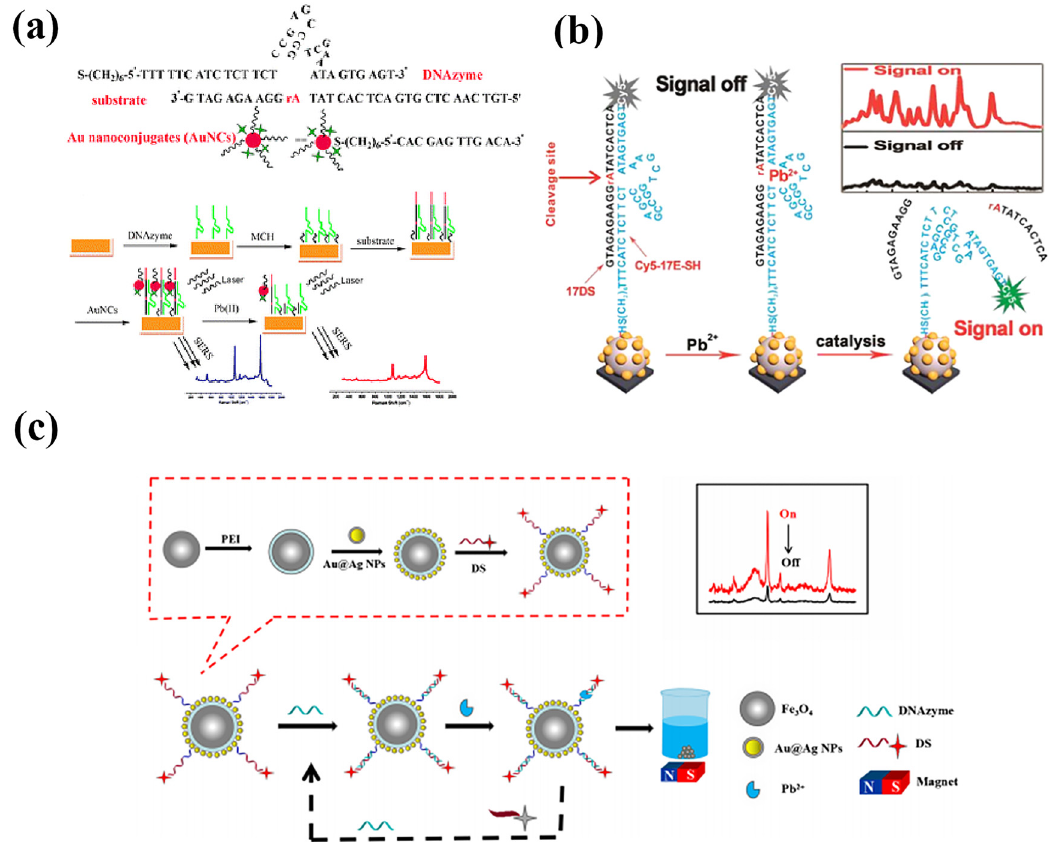
Figure 7: Determination of Pb 2 + ions via Pb 2 + -dependent DNAzyme. (a) Pb 2 + ions bond speci fi cally to the DNAzyme on the gold-plated surface [126]. (b) Cy5 was close to the metal nanoparticles due to the activation of complexation between Pb 2 + ions and DNAzyme [127]. (c) Highly sensitive detection of Pb 2 + ions using DNAzyme-modi fi ed Fe 3 O 4 @Au@AgNPs